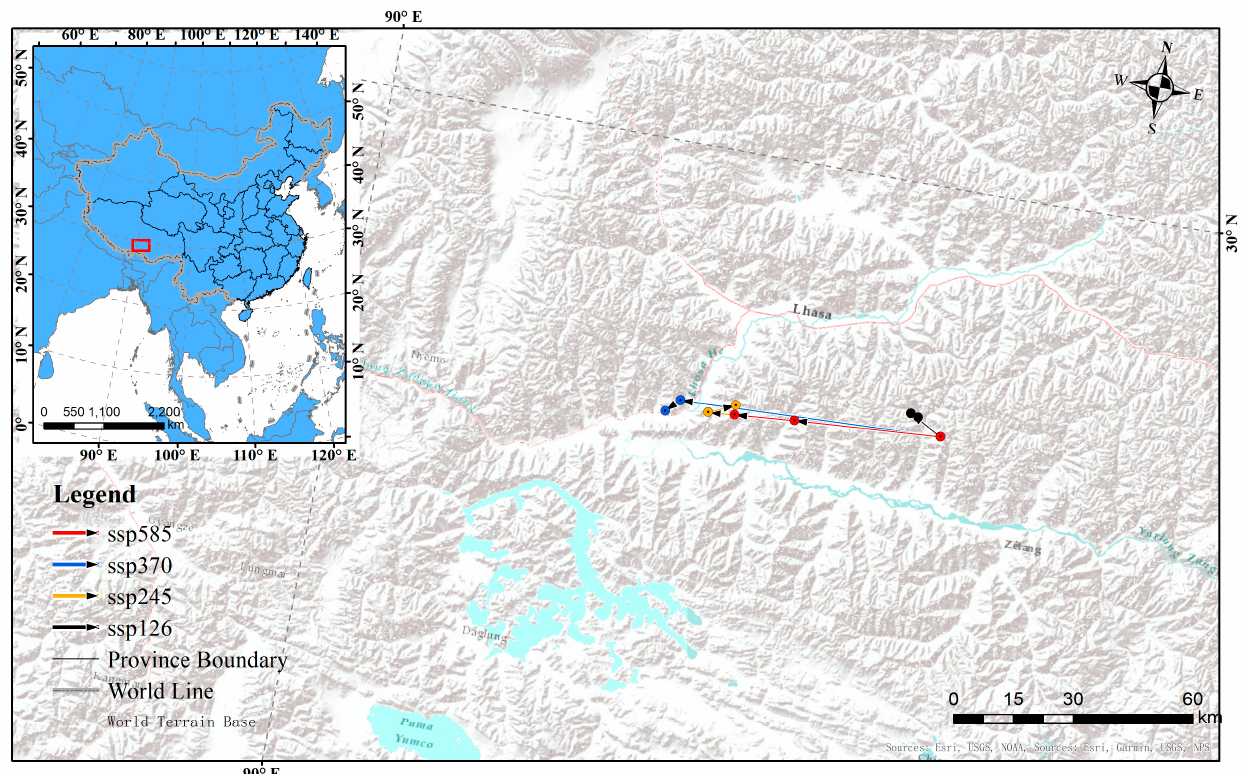
Figure 5. Centroid shifts of the projected habitat distribution for S. moorcroftiana under four emission scenarios (SSP126, SSP245, SSP370, and SSP585).